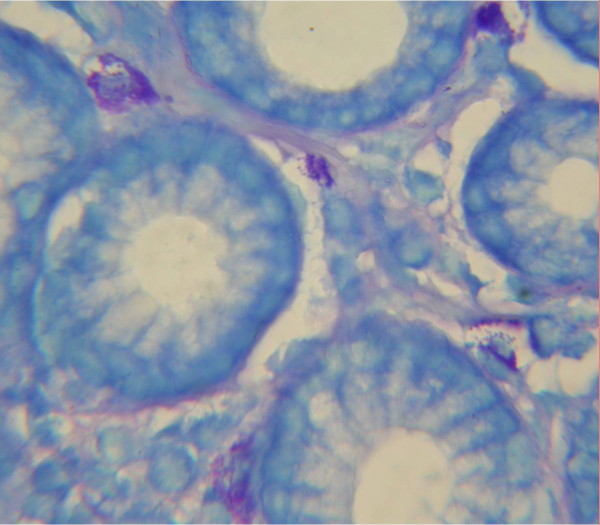
Mast cells are stained by Giemsa staining and are seen best by oil (×1000), in this case five mast cells are seen in this high power field.